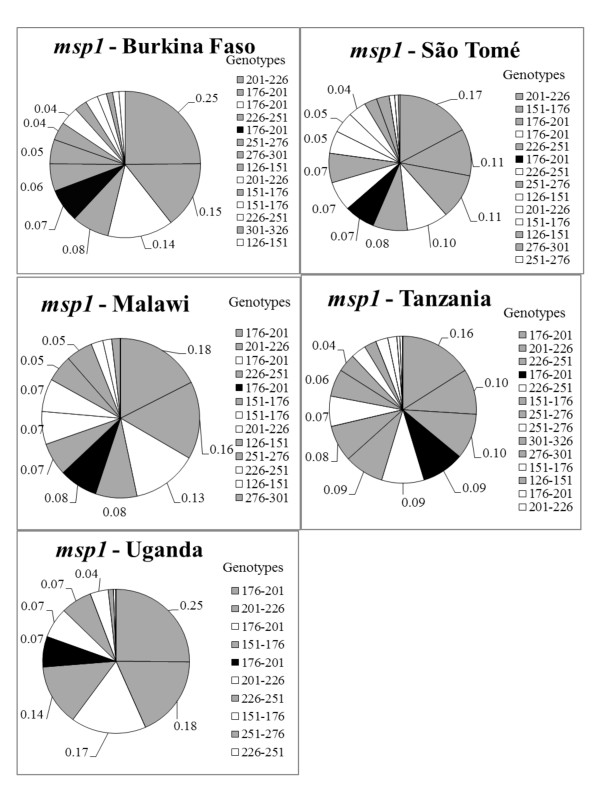
msp1 allelic frequency (%) by country. Most of the genotypes occurred below 10%. Four K1-family genotypes and two MAD20-family genotypes occurred above 10%. Note; only genotypes with frequency ≥ 4% (0.04) are labeled.